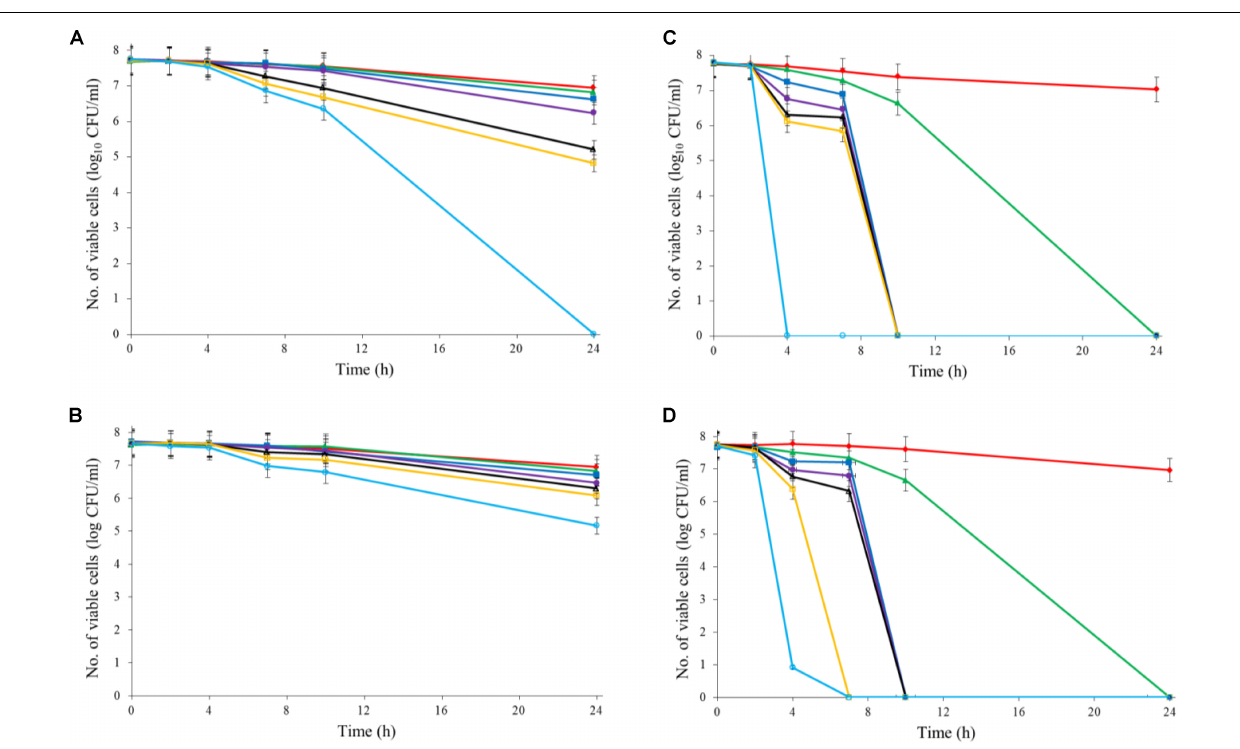
FIGURE 2 | Synergistic antimicrobial effect of ajoene and metal oxide nanoparticles against C. jejuni cocktail (the mixture of C. jejuni strain F38011, ATCC 33560, y110539, and z110526) at 22 ◦ C. (A) Antimicrobial effect of TiO 2 nanoparticles. (B) Antimicrobial effect of Al 2 O 3 nanoparticles. (C) Synergistic antimicrobial effect of 0.06 mM ajoene and TiO 2 nanoparticles. (D) Synergistic antimicrobial effect of 0.06 mM ajoene and Al 2 O 3 nanoparticles. Different symbols indicate different concentrations of metal oxide nanoparticles (red line: 0 mM; green line: 0.5 mM; blue line: 1 mM; purple line: 2 mM; black line: 4 mM; orange line: 8 mM; light line: 16 mM) ( n =